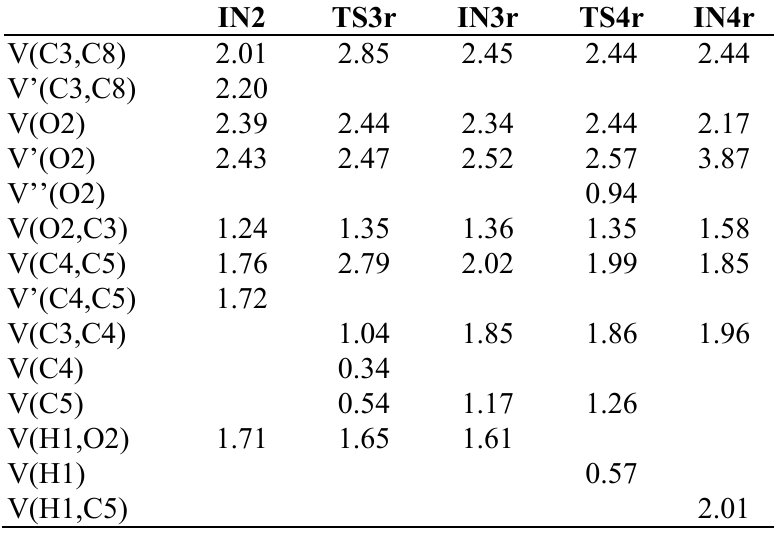
Figure 3. Most relevant ELF attractors at TS3r and TS4r associated with the intramolecular Michael addition in Breslow intermediate IN2